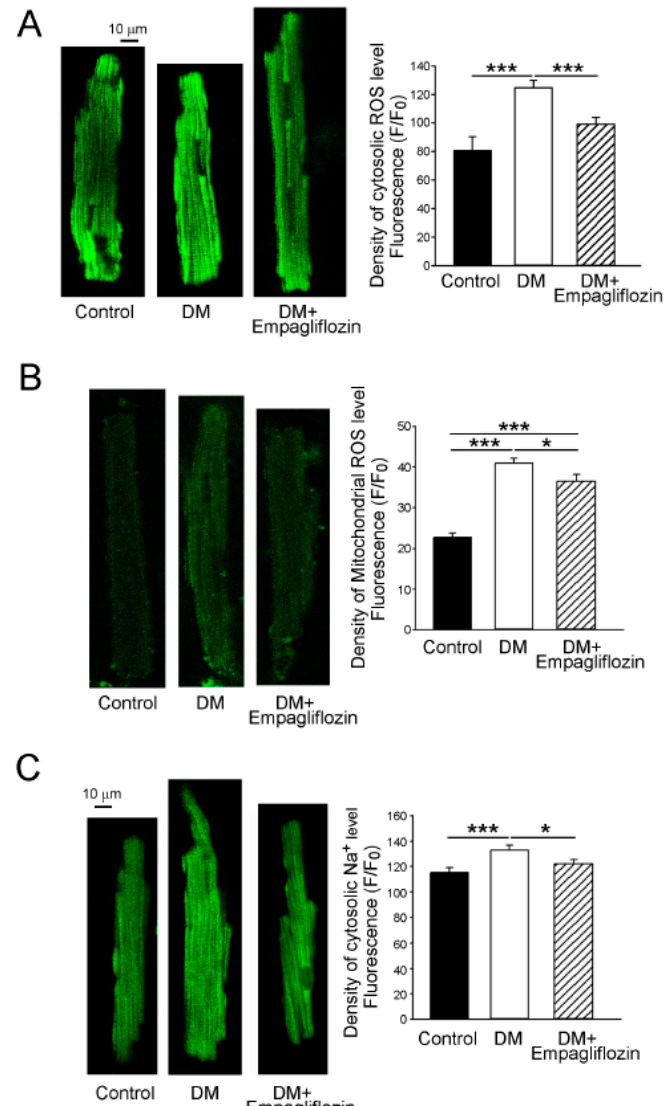
Figure 5. Oxidative stress and cytosolic sodium (Na + ) levels in control, diabetes mellitus (DM), and empagliflozin-treated DM (DM + empagliflozin) ventricular myocytes. ( A ) An example and average data of cytosolic levels of reactive oxygen species (ROS) in control ( n = 21), DM ( n = 28), and DM + empagliflozin ( n = 46) ventricular myocytes. ( B ) An example and average data of mitochondrial levels of ROS in control ( n = 50), DM ( n = 38), and DM + empagliflozin ( n = 28) ventricular myocytes. ( C ) An example and average data of cytosolic Na + levels in control ( n = 29), DM ( n = 22), and DM + empagliflozin ( n = 27) ventricular myocytes. n = number of cardiomyocytes isolated from those rats; * p < 0.05; *** p < 0.005.